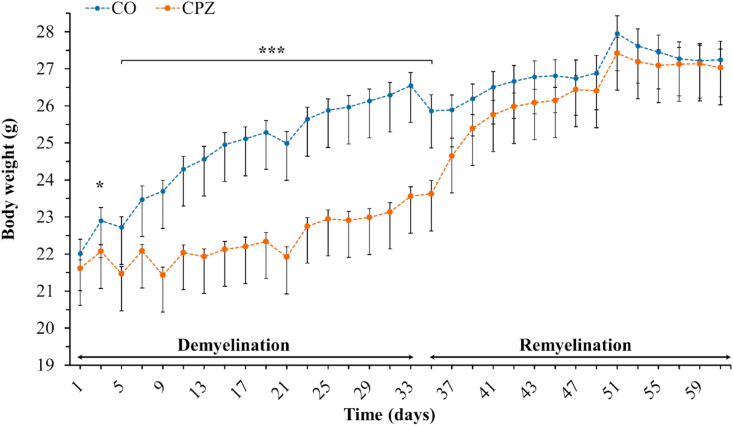
Changes in body weight of the animals during observation. CO controls, depicted with blue dots; CPZ cuprizone treated animals are highlighted with orange dots within two periods (demyelination- and remyelination phase) indicated with black arrows. ∗p < 0.05 vs. CO, ∗∗∗p < 0.001 vs. CO.